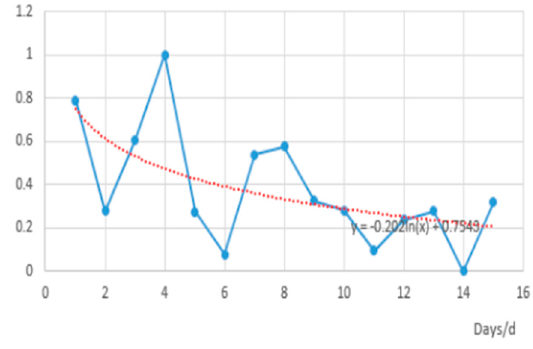
Figure 10. Standard deviation chart.